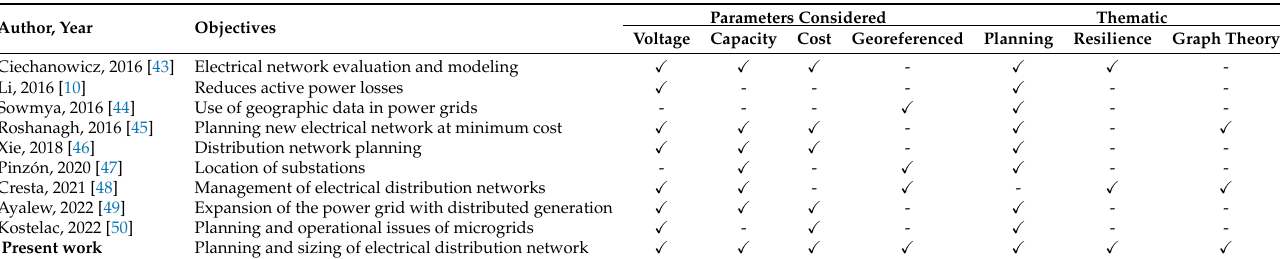
Table 1. Summary of related